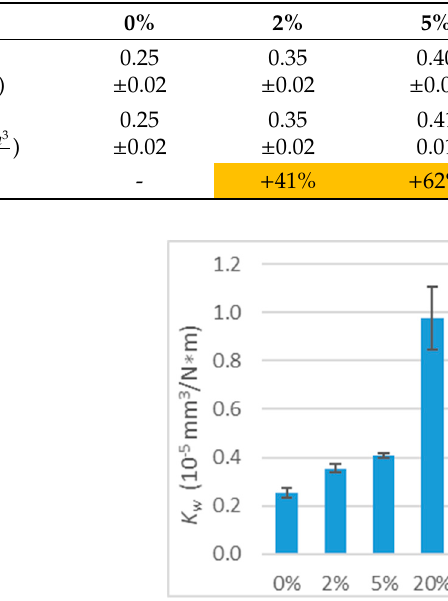
Figure 10. Wear coe ffi cient ( K w ) of deformed polymer (working with steel, tension, perpendicular Figure 10. Wear coefficient ( K w ) of deformed polymer (working with steel, tension, perpendicular direction, v = 0.33 m / s, and T 0 = 23 ◦ direction, v = 0.33 m/s, and T 0 = 23 °C).